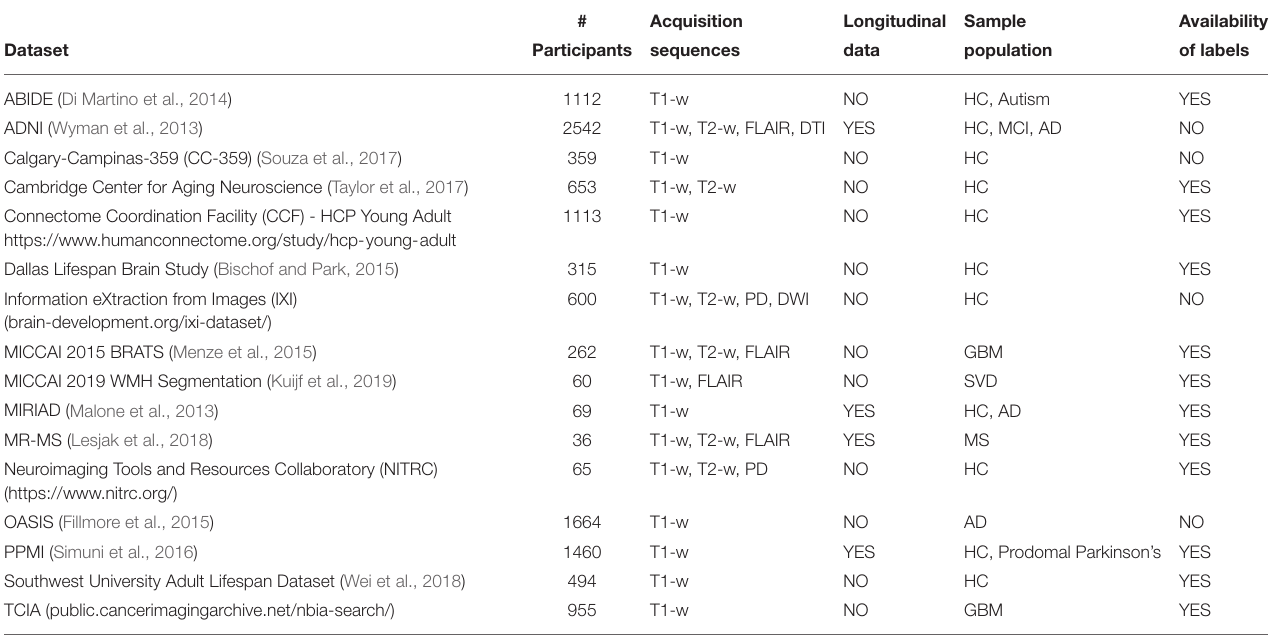
TABLE 1 | Summary of some publicly available MR brain imaging datasets.